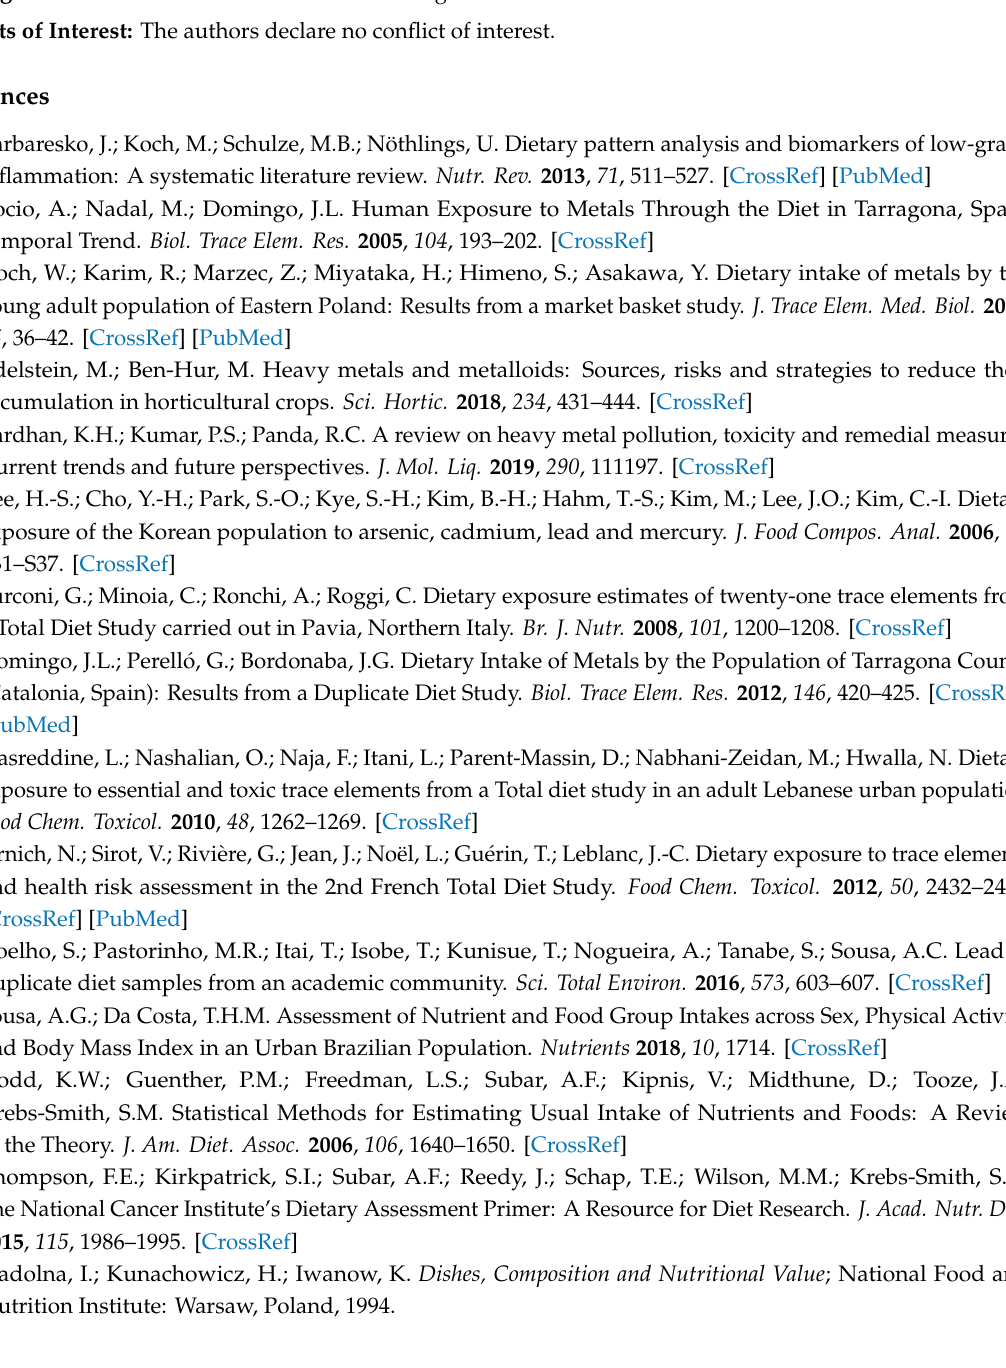
Figure S1: Loadings of first two components of PCA, explaining together 78.86% of information in the dataset obtained for women (A), and 79.55% for men (B). Figure S2: Scores of first two principal components of PCA, explaining together 78.86% of information in the dataset obtained for women (A), and 79.55% for men